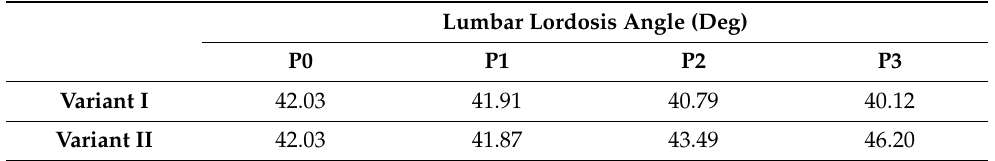
Table 2. The values of the lumbar lordosis angle in measurement sessions: P0—before pregnancy,